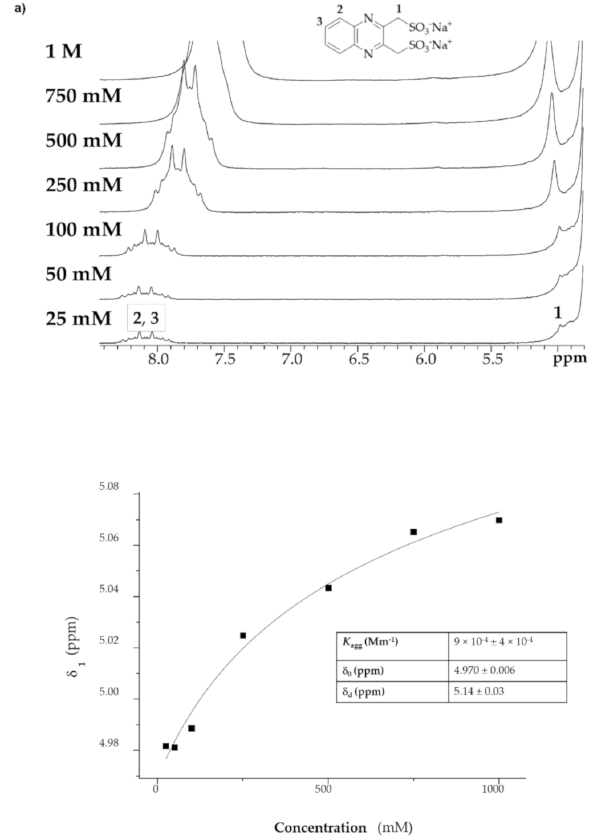
Figure 10. ( a ) 1 H-NMR spectra with increasing concentration of DSMeQUI 20 . ( b ) Non-linear least squares fitting using the Horman and Dreux model to determine the aggregation constant of DSMeQUI 20